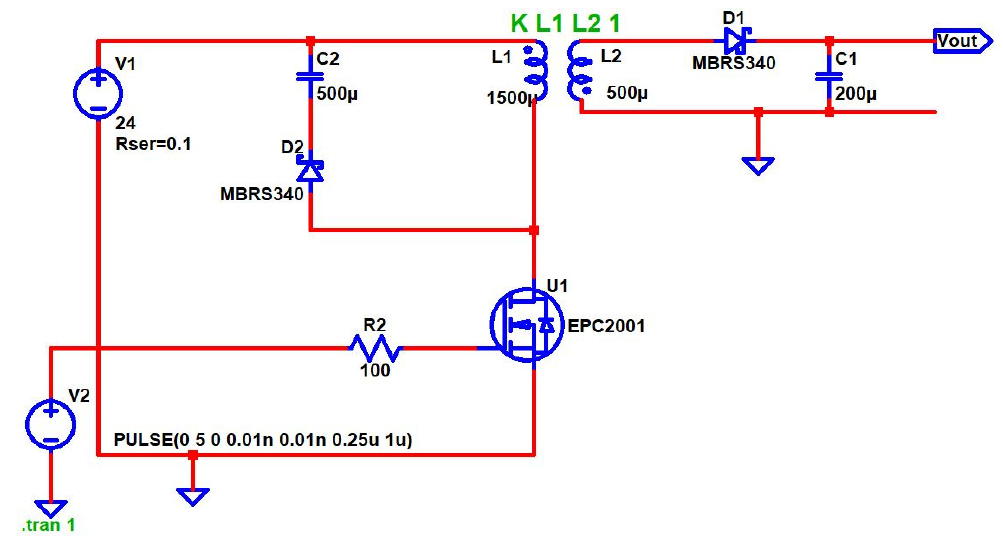
Figure 4. Open-circuit configuration of active flyback DC-to-DC converter.